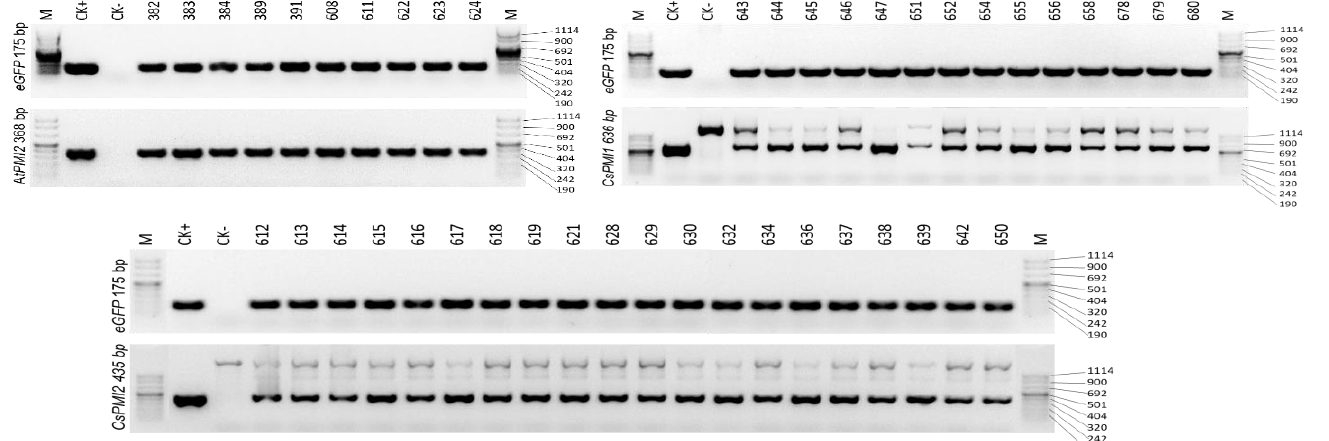
Figure 2. PCR confirmation of the phosphomannose isomerase gene ( PMI ) in mature Kuharske transgenic lines with EGFP and PMI primers. Upper left: M = molecular markers; CK+ = plasmid 2300 AtPMI2 containing AtPMI2 and EGFP genes; CK- = non-transgenic wildtype Kuharske plant; lines 382, 383, 384, 389, 391,608, 611, 622, 623, 624 are the AtPMI2 transgenic lines. Upper right: M = molecular markers; CK+ = plasmid 2300 CsPMI1 containing CsPMI1 and EGFP genes; CK- = non-transgenic wildtype Kuharske plant; lines 643, 644, 645, 646, 647, 651, 652, 654, 655, 656, 658, 678, 679, 680 are the CsPMI1 transgenic lines. Lower: M = molecular markers; CK+ = plasmid 2300 CsPMI2 containing CsPMI2 and EGFP genes; CK- = non-transgenic wildtype Kuharske plant; lines 612, 613, 614, 615, 616, 617, 618, 619, 621, 628, 629, 630, 632, 634, 636, 637, 638, 639, 642, 650 are the CsPMI2 transgenic lines.